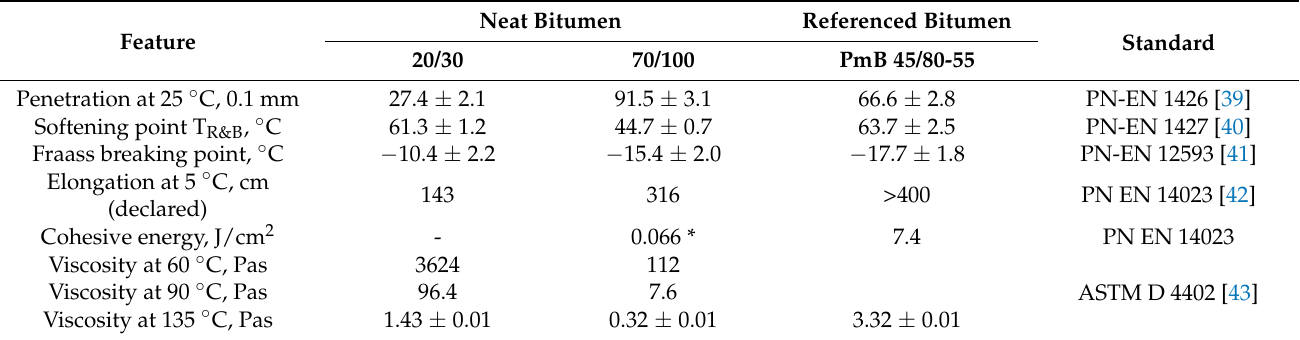
Table 1. Results of road paving bitumen